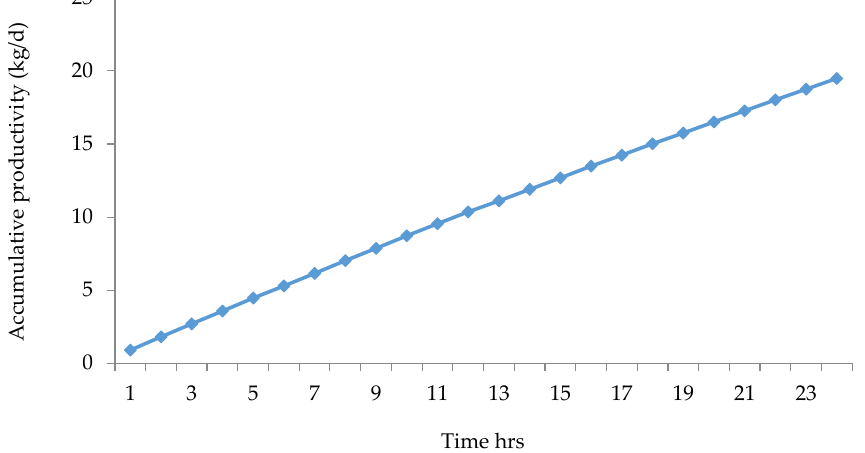
Figure 6. Cumulative distillate production rate on 26 September 2020.